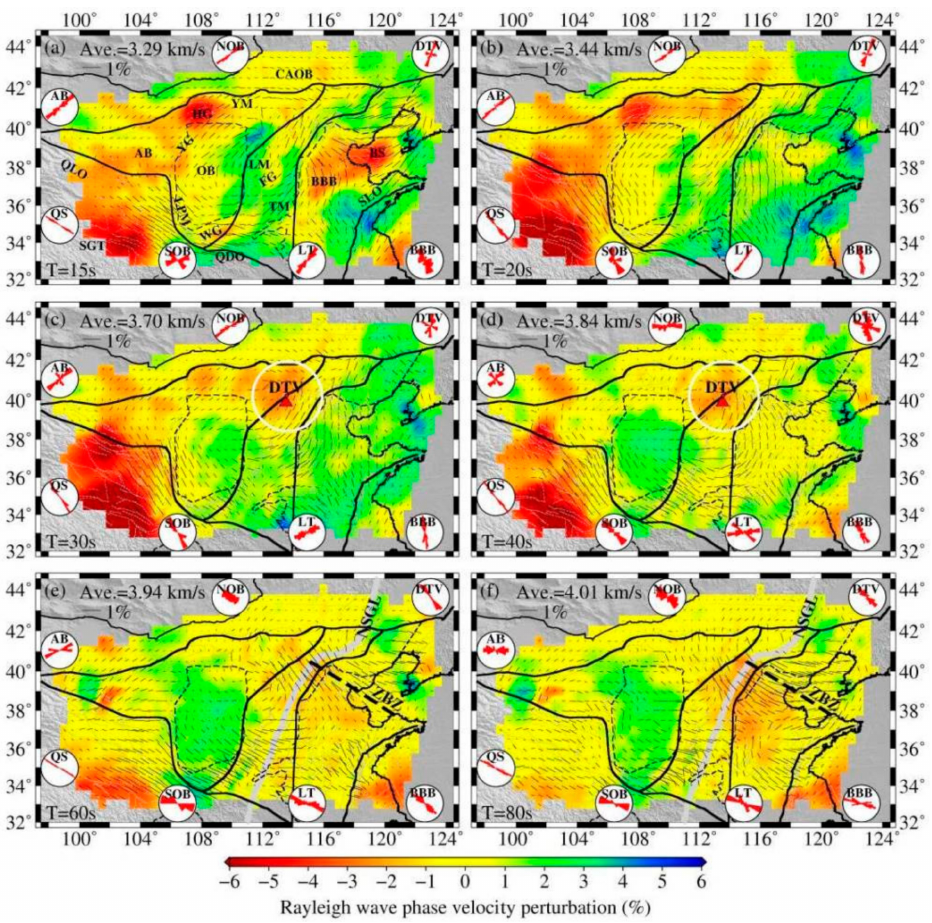
Figure 7. Examples of Rayleigh wave phase velocity and azimuthal anisotropy at 15, 20, 30, 40, 60 and 80 s periods. The abbreviations of geological units are defined in the caption of Figure 1. The black error bar denotes the magnitude and fast wave direction of azimuthal anisotropy. The average Rayleigh wave phase velocity (Ave.) at each period is shown in the corresponding panel. The red rose diagrams indicate the statistical direction of the fast axis in the Alax block (AB), Qilian orogen and Songpan–Ganzi terrane (QS), south Ordos block (SOB), north Ordos block (NOB), Lüliang and Taihang mountain (LT), Bohai bay basin (BBB) and Datong volcano